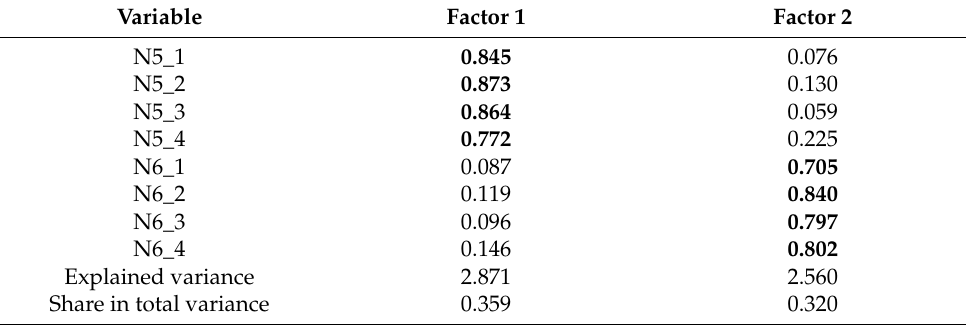
Table 8. Factor loadings of joint items sets assessing PwD types.